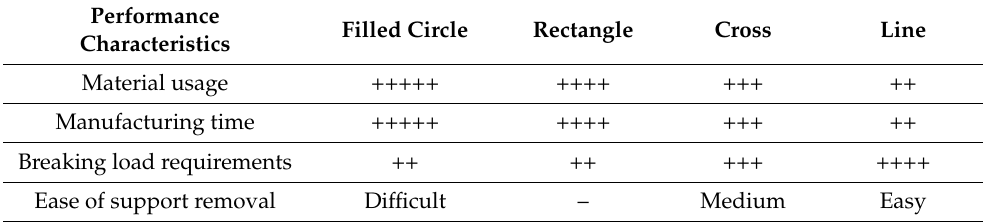
Table 5. Performance comparison of the integrative experimental